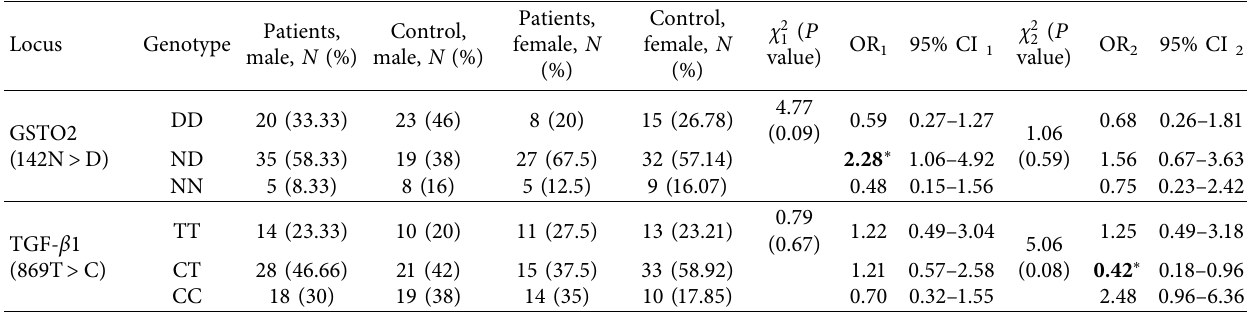
χ 2 1 and χ 2 2 are the associations between genotype distribution and patients/control groups in male and female. OR 1 and OR 2 are the odds of each genotype to referenceinthepatientsgroup/the oddsofeachgenotype toreference for thecontrolgroupinmale andfemale. CI 1 and CI 2 aretheconfidence intervalofOR 1 and OR 2 in each gender group. ∗ P value < 0.05.